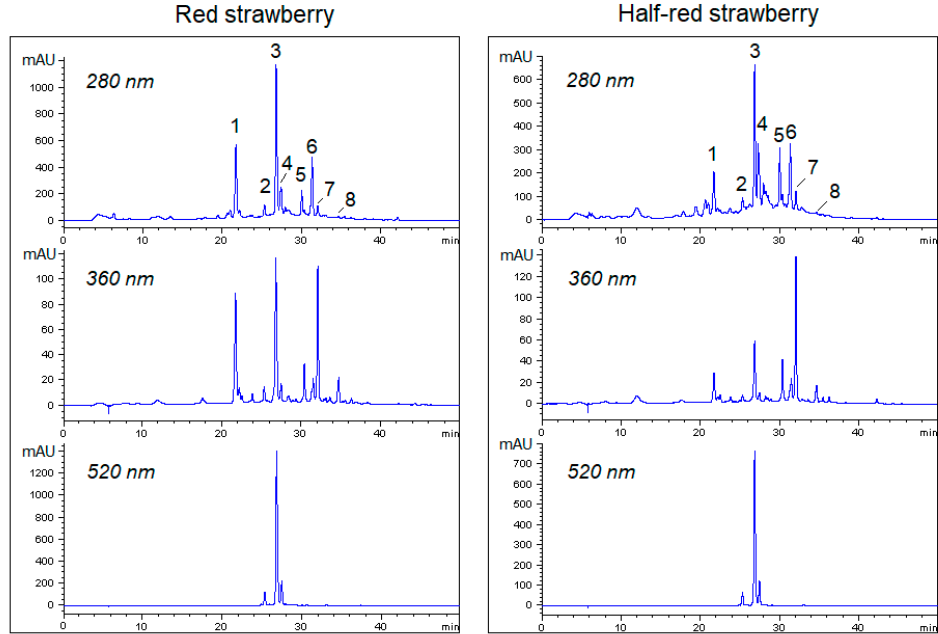
Figure 2. RP-HPLC chromatograms of extracts from red ( left ) and half-red ( right ) “Candonga” strawberries. Numbers (1–8) above the peaks correspond, respectively, to the codes P1–P8 reported on Table 2.